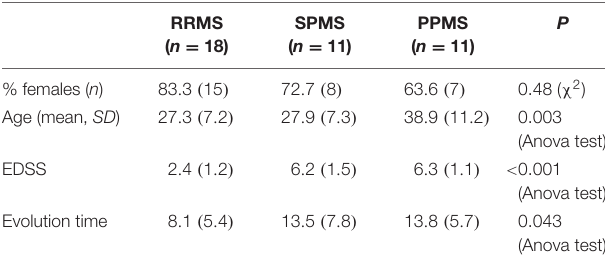
TABLE 3 | Primer sequences and amplification summary.